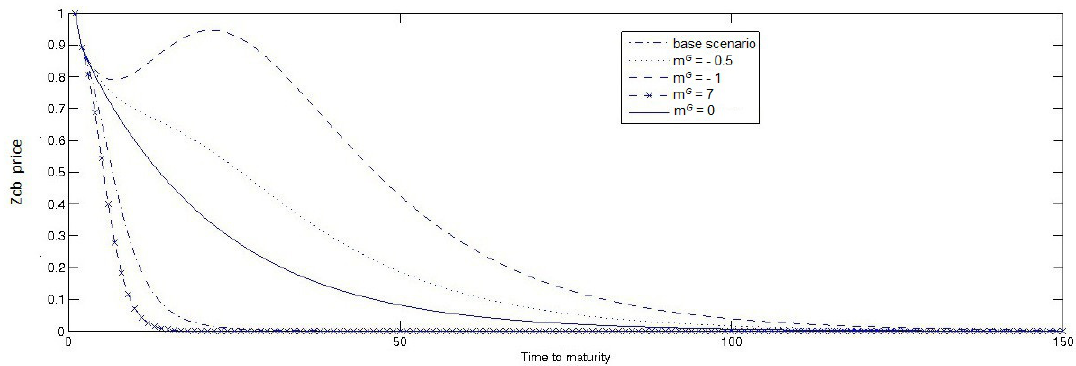
Figure 1. Zero coupon bond price in different government action hypotheses .